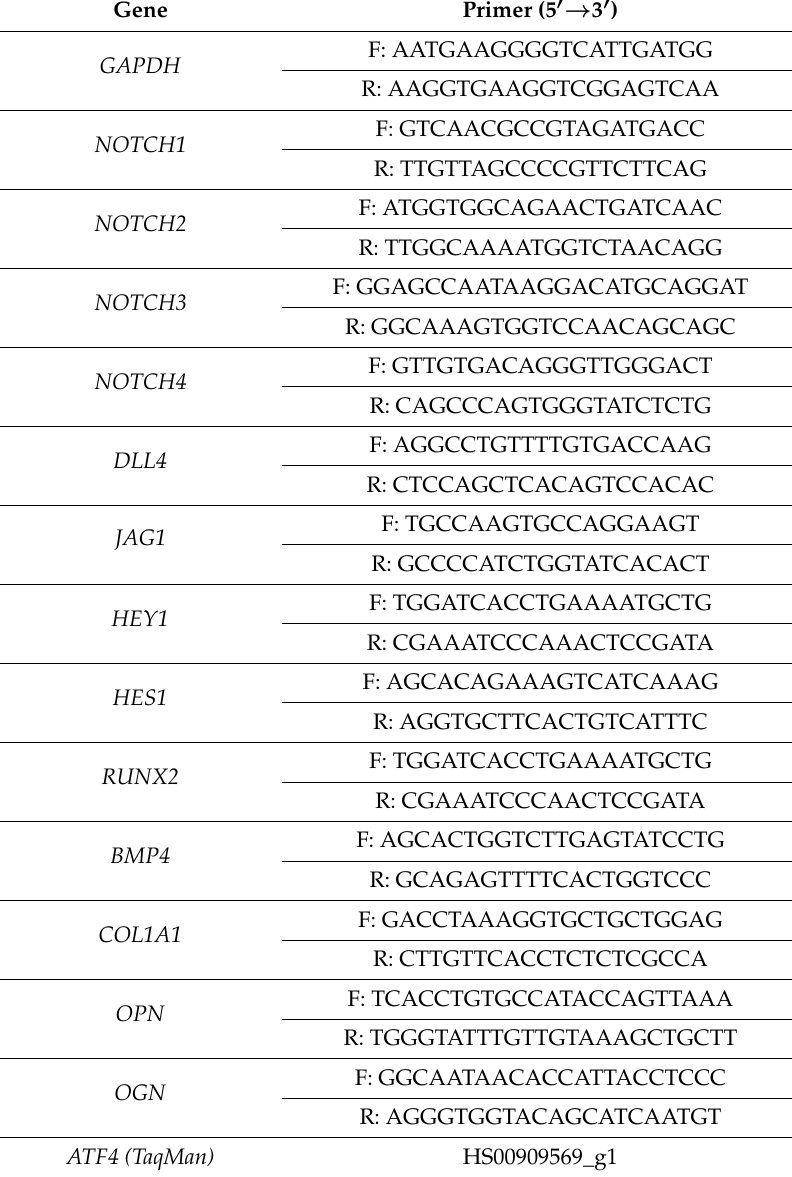
Table 1. Primer sequences used for to amplify Notch target genes and osteogenic differentiation markers by